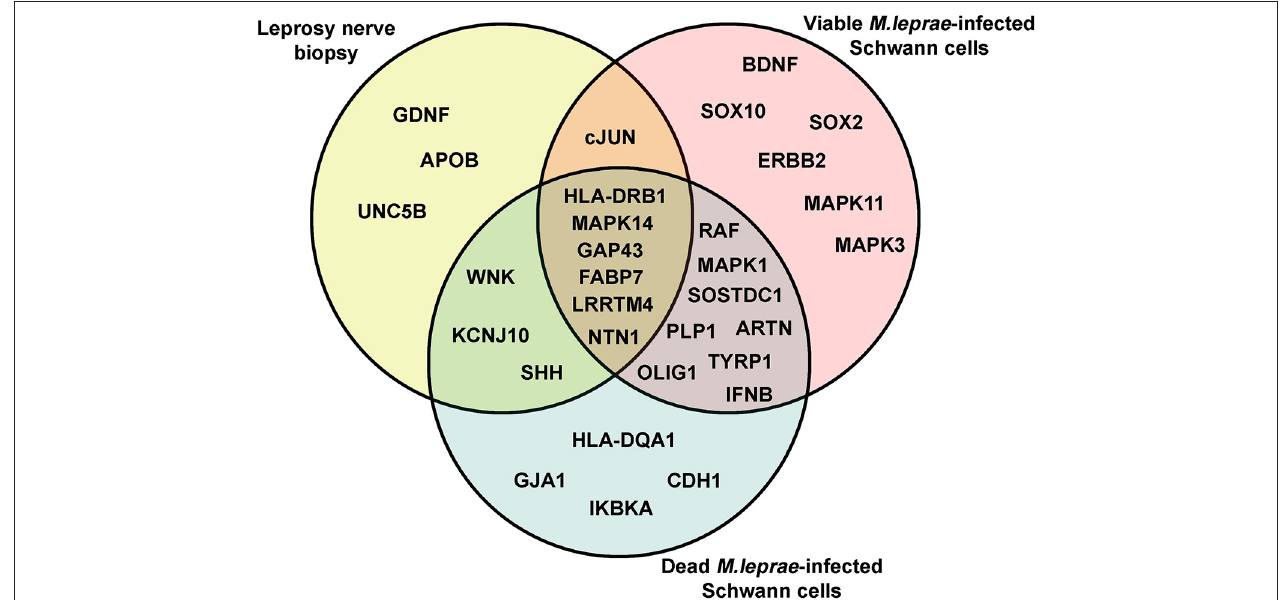
FIGURE 2 | The Venn diagram of differentially upregulated genes related to Schwann cell biology genetic signature in leprosy. The Venn diagram was used to identify clusters of overlapping and non-overlapping mRNA transcripts, upregulated in leprosy nerve biopsies and in Schwann cells infected with viable and dead M. leprae .